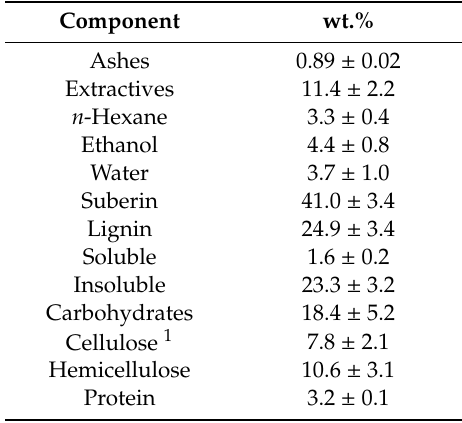
Table 1. Composition of granulated cork on a dry weight basis.